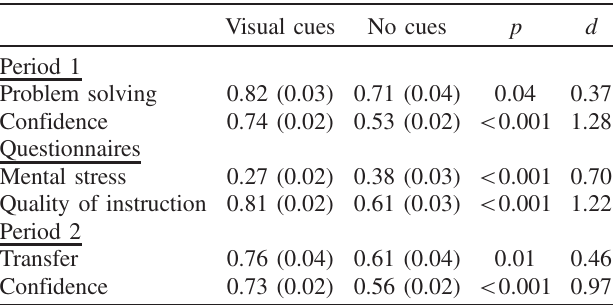
TABLE V. Descriptive data on all outcome variables (means and standard errors in parentheses) and ANOVA